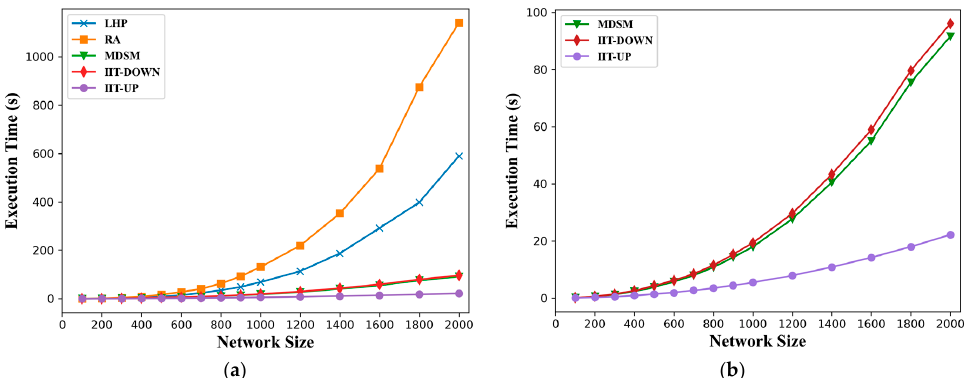
Figure 7. Execution time comparison of each algorithm with different network sizes. IIT algorithms